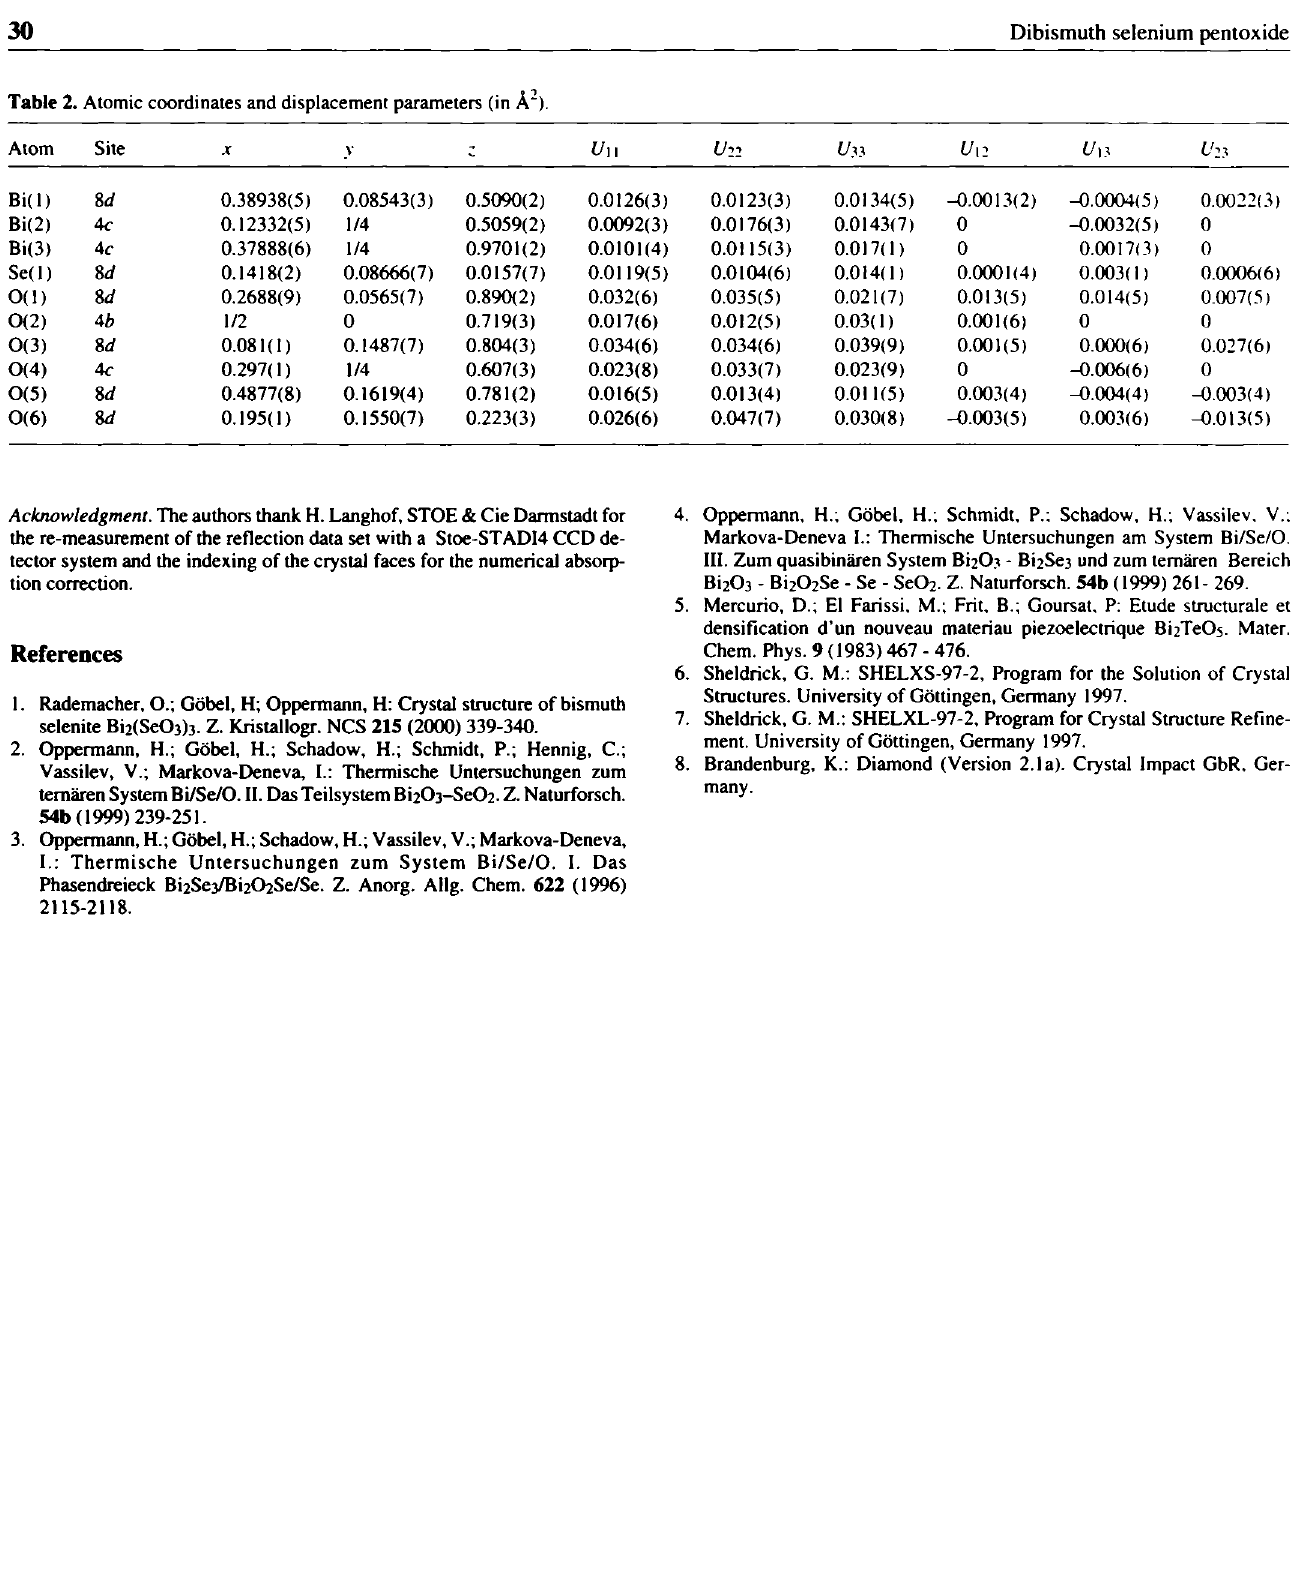
Table 2. Atomic coordinates and displacement parameters (in A 2 ).